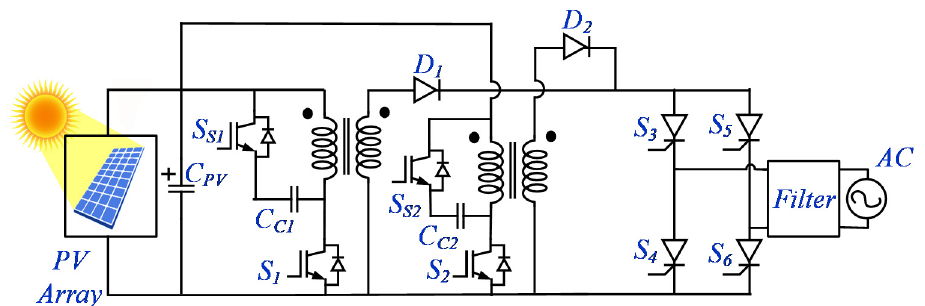
Figure 27. Interleaved fly-back inverter with soft switching.